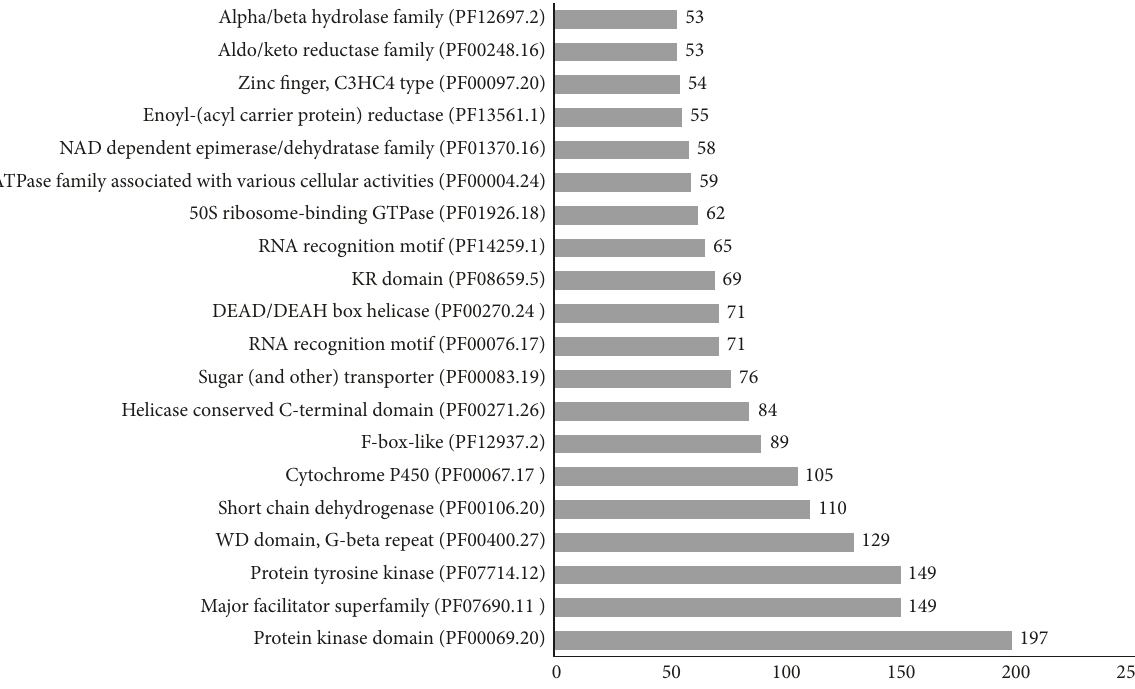
Figure 4: A summary for the top 20 Pfam protein domains of S. latifolia